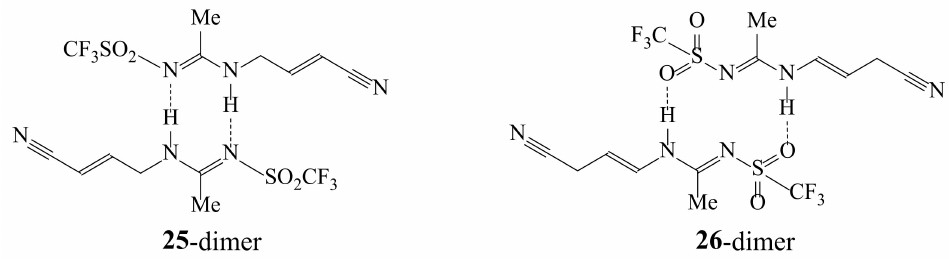
Figure 1. Optimized structures of the cyclic dimers of isomers 25 and 26